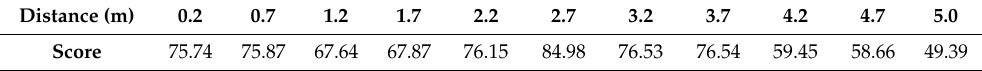
Table 3. The scores of the subjects completing the task under different depth distances. Distance